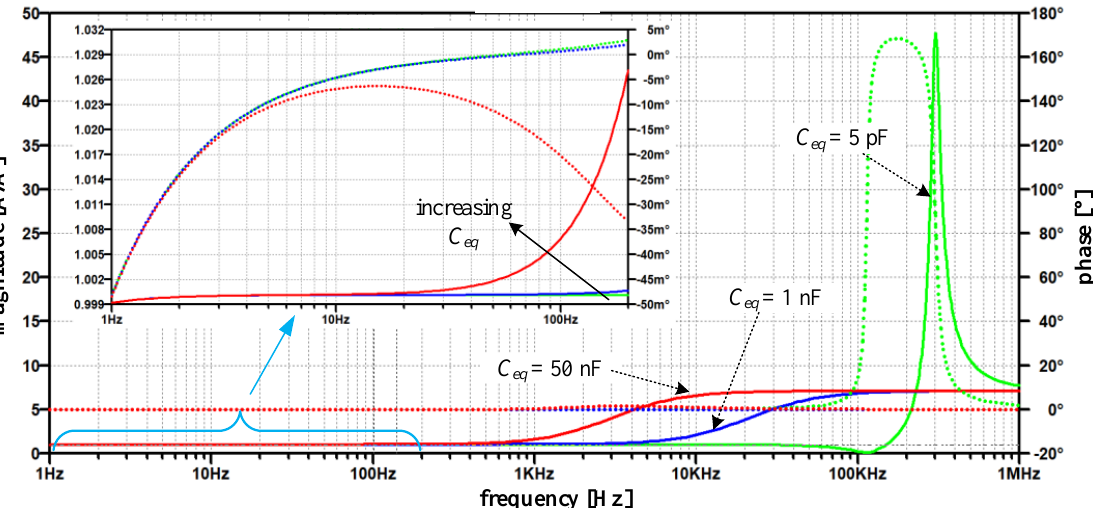
phase [°] Figure 8. Simulated frequency response Y (magnitude-solid line, phase — dotted line) with original and modified amplifier for varying C eq : ( a ) original amplifier; ( b ) modified amplifier.